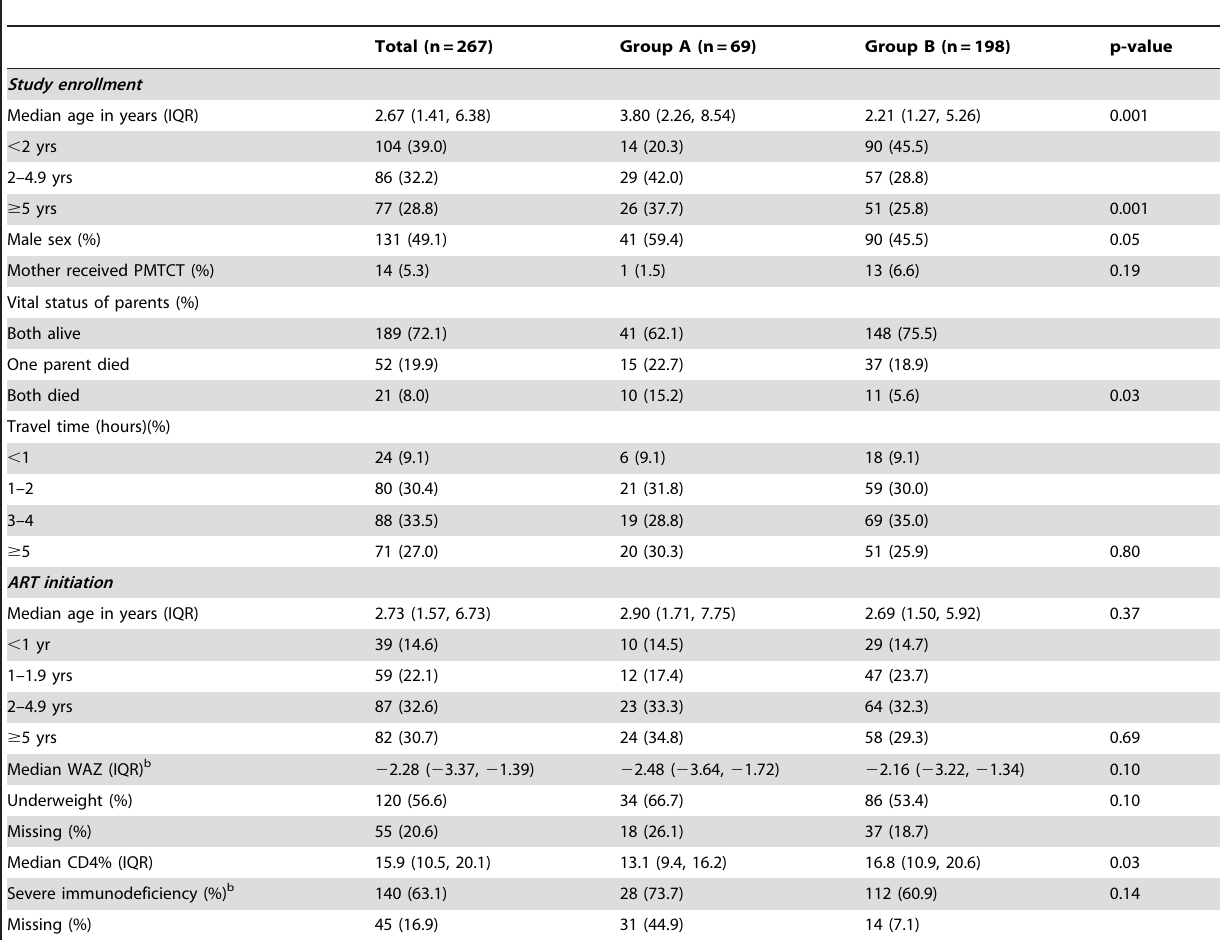
Table 1. Characteristics at study enrollment and ART initiation of HIV-infected children receiving antiretroviral therapy.